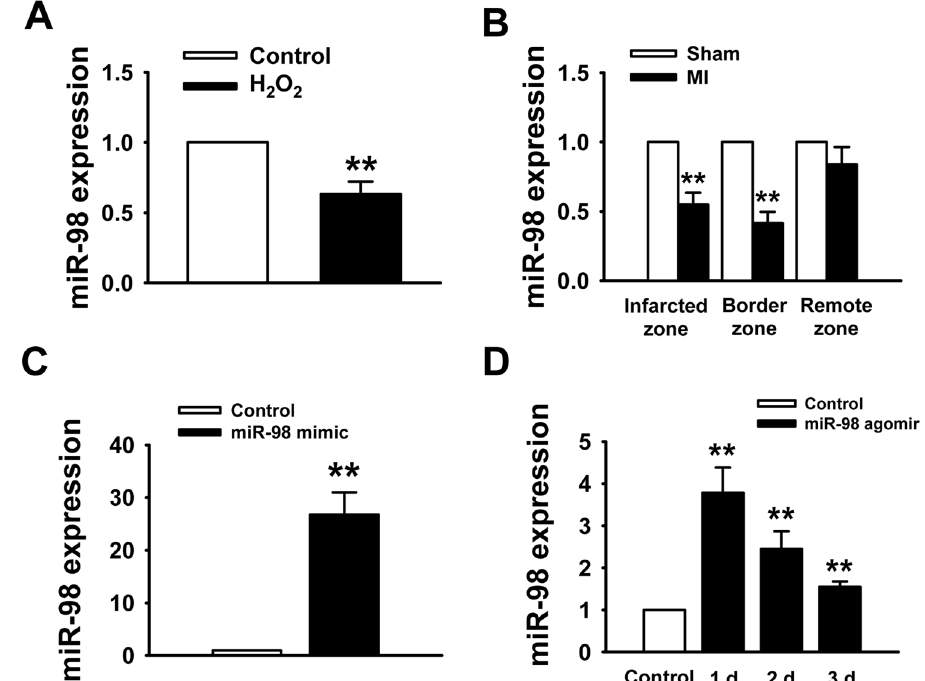
Figure 1. MiR-98 is downregulated in MI mice model and H 2 O 2 -treated NRVCs. ( A ) Real-time PCR data showed the downregulation of miR-98 expression in NRVCs treated with 100 μ M H 2 O 2 for 4 h. n = 6. ( B ) miR- 98 is decreased in the infarcted and border zones of MI mice compared with sham mice. n = 3. ( C ) miR-98 expression level in NRVCs after miR-98 mimic transfection. n = 6. ( D ) miR-98 expression level in rat ventricles after administration with miR-98 agomir. n = 3. ** P < 0.01 vs. Control or